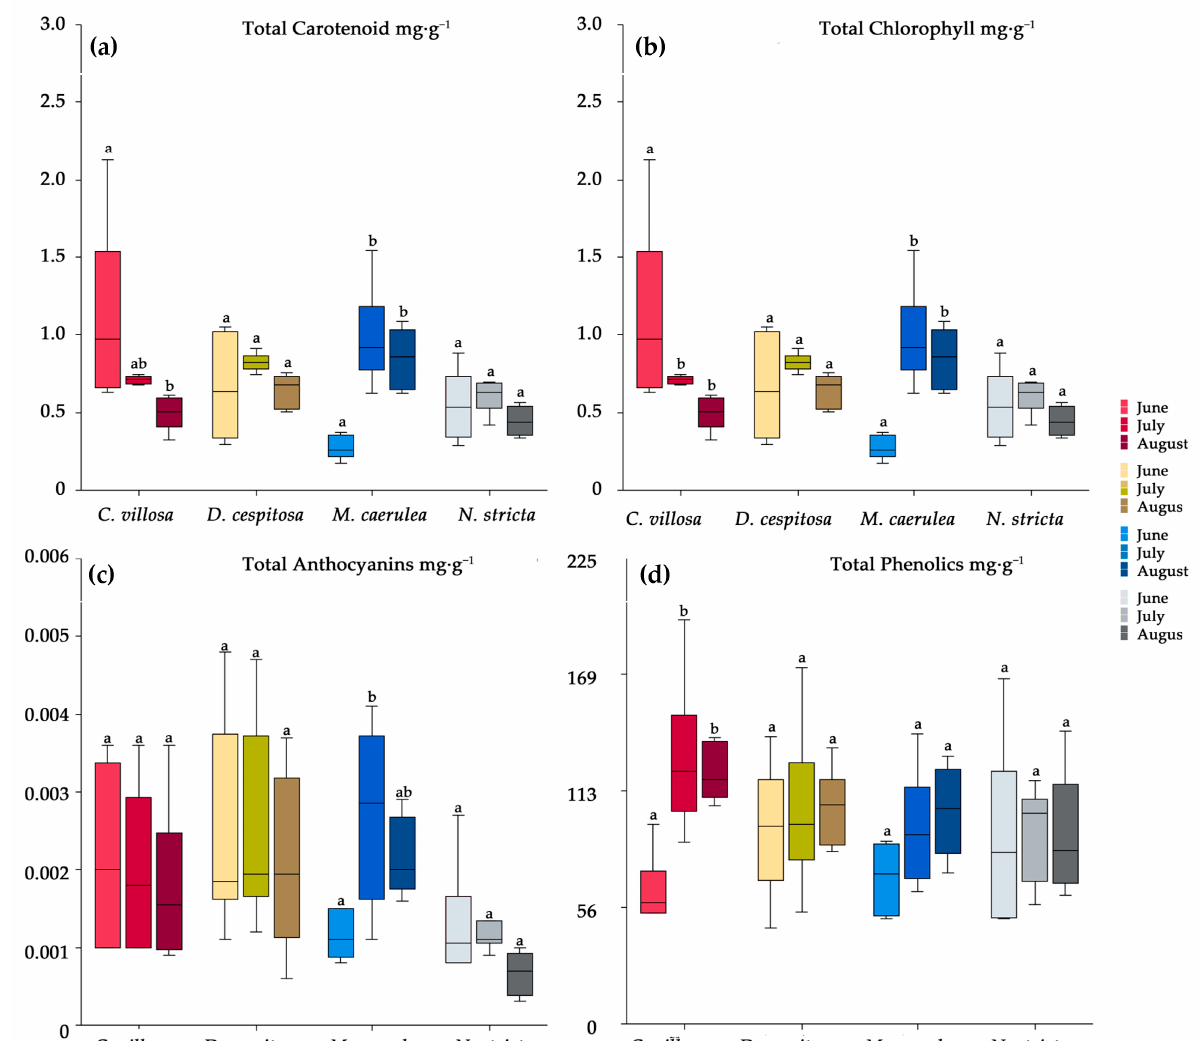
Figure 6. The seasonal dynamics of total carotenoids ( a ), chlorophyll ( b ), anthocyanins ( c ), and phenolics ( d ) for Calamagrostis villosa (red boxes), Deschampsia cespitosa (yellow boxes), Molinia caerulea (blue boxes), and Nardus stricta (grey boxes) measured in 2020; n = 6 per species per month. Medians (central line); 25 and 75 percentiles (boxes); 1.5 interquartile range (error bars). Different letters denote significance according to the Kruskal–Wallis multiple-comparison Z-value test ( α = 0.05) across species.